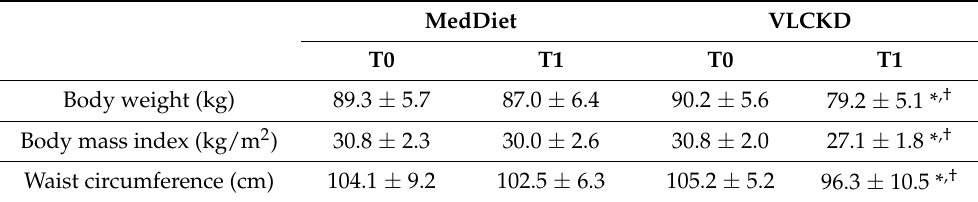
Table 1. Bodyweight, body mass index (BMI), and waist circumference of patients with male accessory gland inflammation before (T0) and after three months (T1) on a Mediterranean diet (MedDiet) or very-low-calorie ketogenic diet